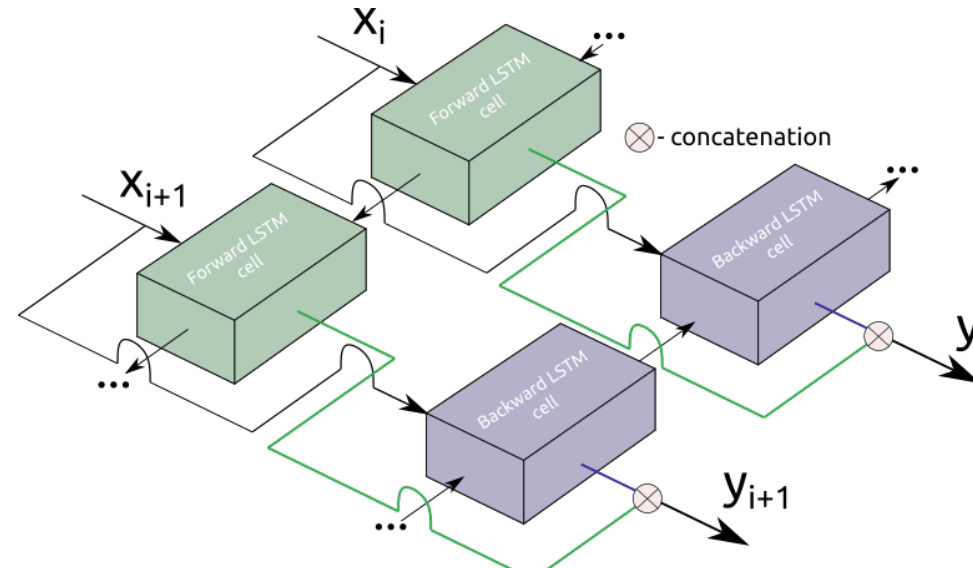
Figure 6. The core idea standing behind the bidirectional LSTM used in the ConvBiLSTMNet is as follows–to prevent losing a context by the cell, process a sequence from the beginning to the end, do the same in the reversed direction and concatenate both passes . Input x i refers to the i -th feature vector returned by the convolutional